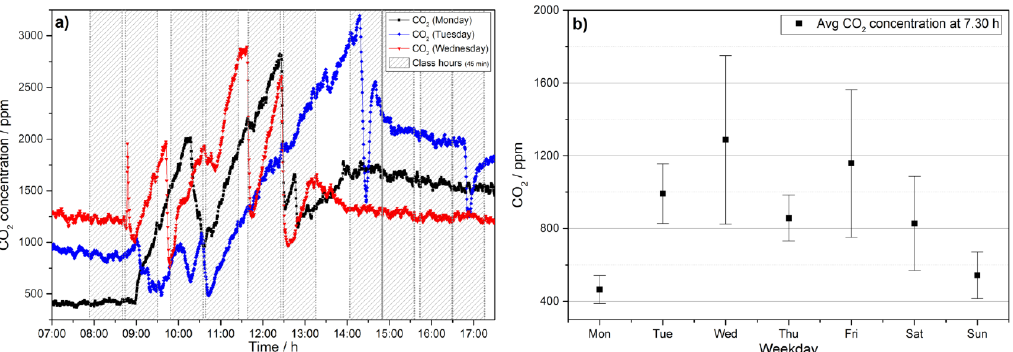
Figure 7. ( a ) Exemplary dynamics of the evolution of the CO 2 level on three days of the week. Because doors and windows are closed after school finished CO 2 can accumulate. ( b ) The accumulation leads to a constant increase in the background level of CO 2 , which makes it harder to maintain good CO 2 levels the older the week gets.